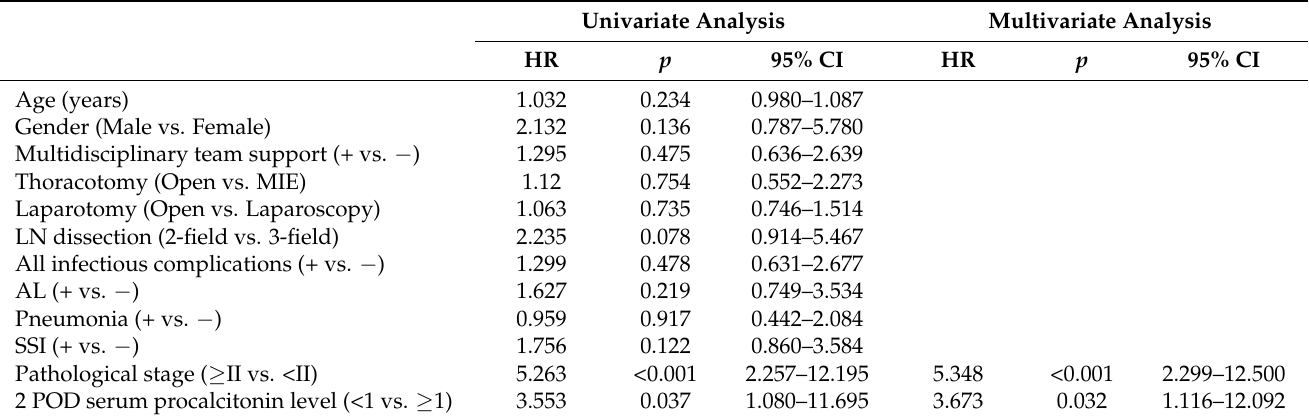
Table 3. Independent factors of clinicopathological, surgical, and pathological features on shorter overall